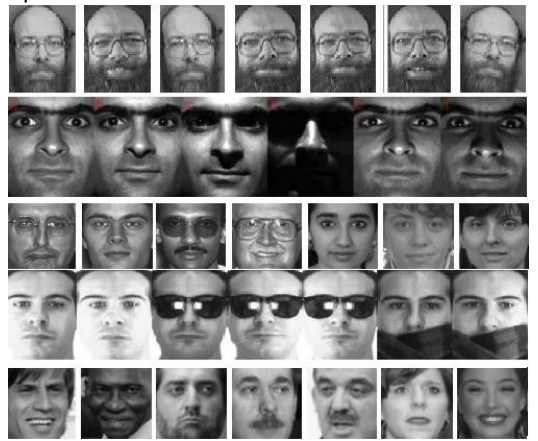
Figure 4. Some samples of datasets. From top to bottom: ORL, Extended YALE B, FERET, AR And LFW